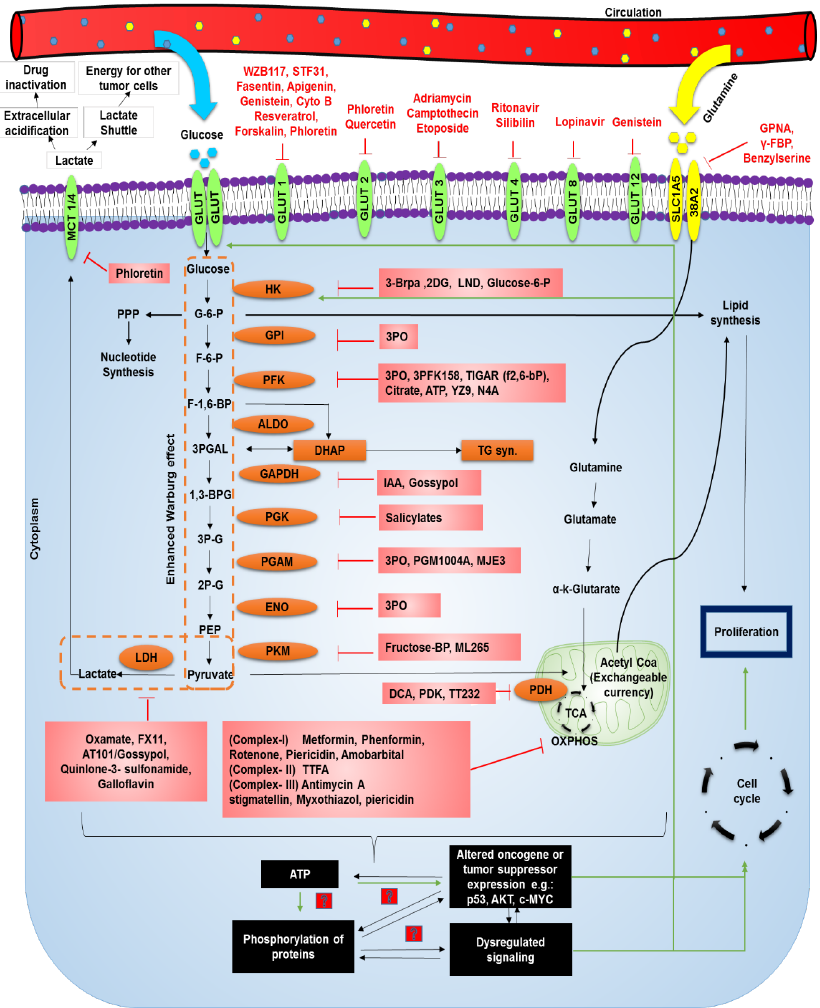
Figure 2. Hyperglycemia associated metabolic reprogramming in cancer cells and potential targets. Pathways altered due to hyperglycemia leading to proliferation are indicated by green arrows. Inhibitors of various molecules are indicated in red. The inhibitors presented here and the corresponding clinical or research studies are mentioned in Table 1 with their respective targets. STF31: 4-[[[[4-(1,1-Dimethylethyl)phenyl]sulfonyl]amino]methyl]-N-3-pyridinyl-benzamide; CYTO B: Cytochlasin B; GPNA: L- γ -Glutamyl-p-nitroanilide; FBP: Fructose-1,6-bisphosphate; GLUT: Glucose transporter; MCT: Monocarboxylate transporter; PPP: Pentose Phosphate Pathway; G6P: Glucose-6-phosphate; F6P: Fructose-6-phosphate; F1,6BP: Fructose-1,6-bisphosphate; 3PGAL: Glyceraldehyde-3 phosphate; 13BPG: 1,3 Bisphosphoglyceric acid; 3PG: 3-phosphoglycerate; 2PG:2-phosphoglycerate; PEP: Phosphoenol pyruvate; HK: Hexokinase; GPI: Glucose-6 phosphate isomerase; PFK: Phosphofruktokinase-1; ALDO: Aldohexose; DHAP: Dihydroxyacetone phosphate; GAPDH: Glyceraldehyde 3-phosphate dehydrogenase; PGK: Phosphoglycerate kinase; PGAM: Phosphoglycerate mutase-1; ENO: Enolase; PKM: Pyruvate kinase M1 / M2; TG: Triglyceride; 3BRPA: 3 Bromopyruvic Acid; 2DG: 2-deoxyglucose; LND: Lonidamine; 3PO: (2E)-3-(3-Pyridinyl)-1-(4-pyridinyl)-2-propen-1-one; TIGAR: TP53-inducible glycolysis and apoptosis regulator; ATP: Adenosine triphosphate; IAA: 1-O-Indol-3-ylacetyl-beta-D-glucose; DCA: Dichloroacetic acid; PDK: Pyruvate Dehydrogenase kinase; LDH: Lactate Dehydrogenase; OXPHOS: Oxidative